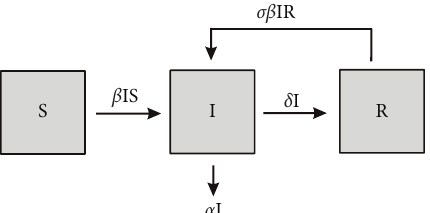
Figure 1: Flowchart of the variant of model SIRI considered. This is the well-known SIR model without vital dynamics, with its term of reinfection σβ RI and modified by the term of disease-induced death α I